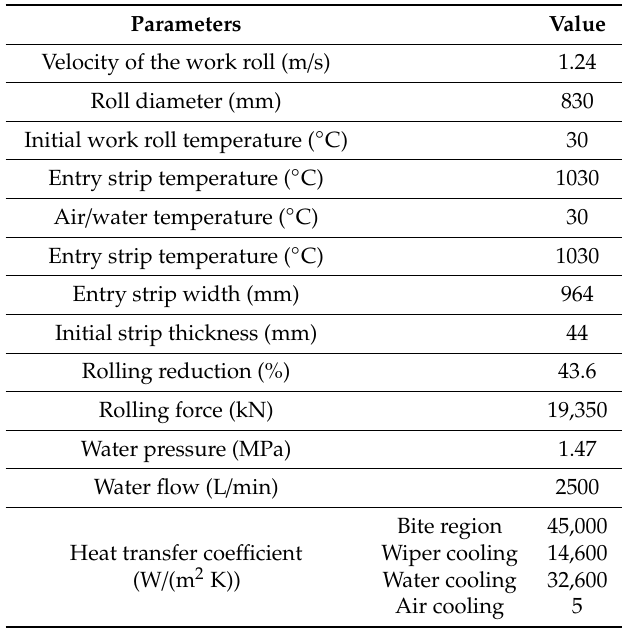
Table 1. Rolling parameters of the finishing stand F1 during hot stir rolling used in the finite element method (FEM) simulation.